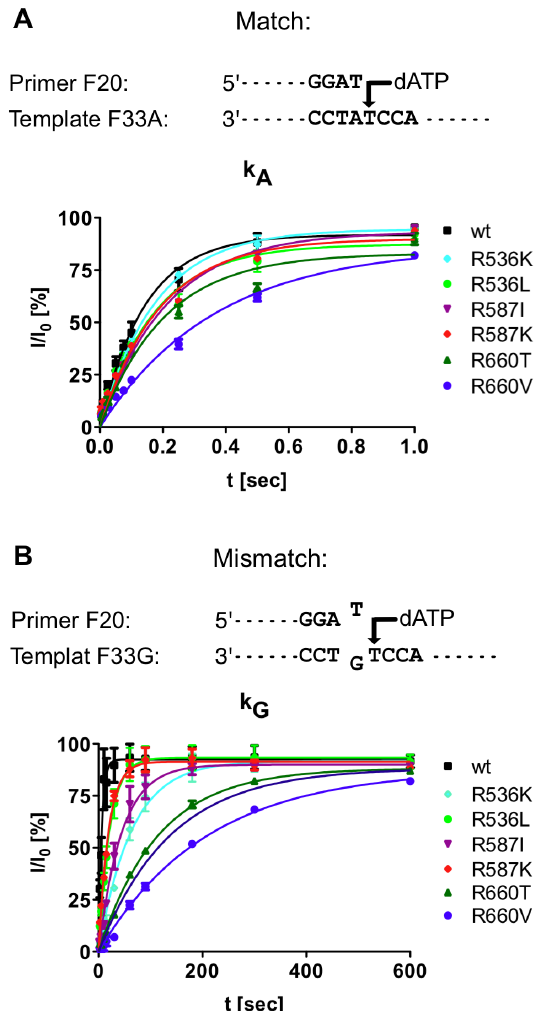
Figure 3. Single turnover rates (pre-steady-state). A) Conversion of primer vs. time for the match case. B) Conversion of primer vs. time for the mismatch case.